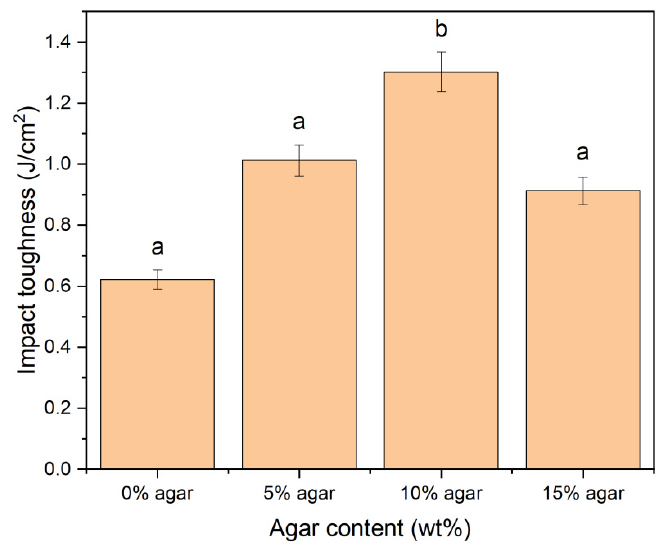
Figure 7. Impact toughness of TPSS/agar. Letters a and b in the figure indicate groups in homogenous subset which has p < 0.05.